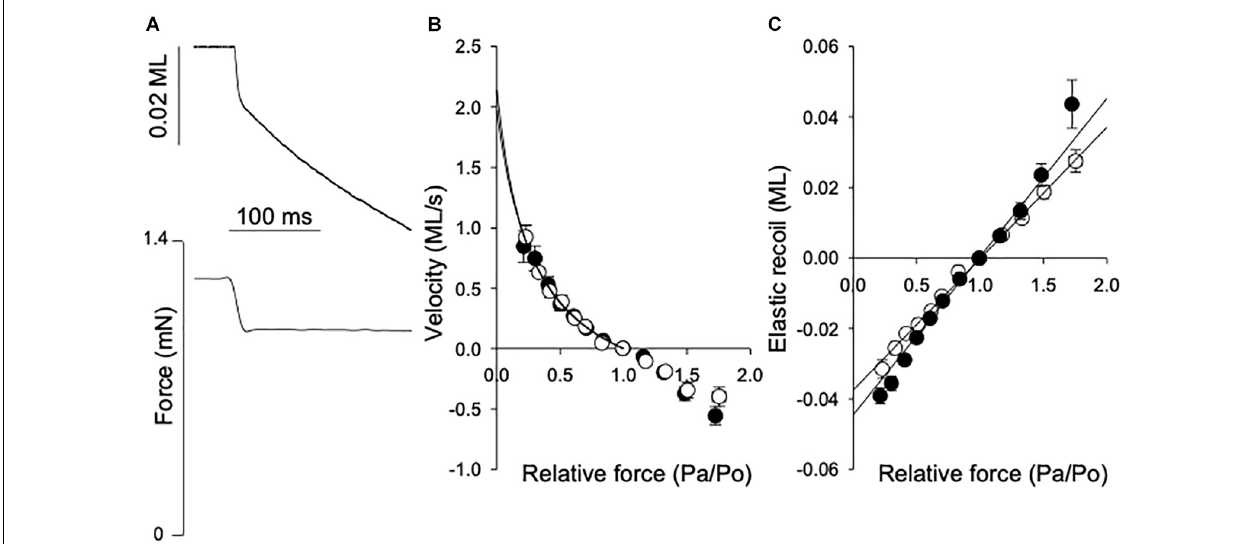
FIGURE 3 | Force-velocity relationship and series elasticity. (A) Shows original traces of the fiber length shortening response (lower) to a rapid change in contraction force (top), from a normal breast muscle. The force step and length response are indicated in the figure. Shortening velocity = reduction in muscle length (ML)/shortening time (s). The afterload force (Pa) and reduction in muscle length were determined between 20 and 70 ms after the force step. (B) Shows the velocity (ML s-1) at different after loads related to the isometric force (Po). Data from 6 experiments were grouped according to Pa/Po and the data for shortening (i.e., velocity ≥ 0) were fitted by the hyperbolic Hill equation (Eq. 1). The equation was extrapolated to Pa/Po = 0 to determine the maximal shortening velocity, Vmax (fit to data in figure: normal breast, open symbols: 2.1; woody breast, filled symbols: 2.0 ML s - 1 ). (C) Depicts the initial elastic recoil for different force steps. The data between 0.5 and 1.5 Pa/Po were fitted by a straight line [Normal breast, open symbols: 0.037; woody breast, filled symbols: 0.045 ML (Pa/Po)-1].